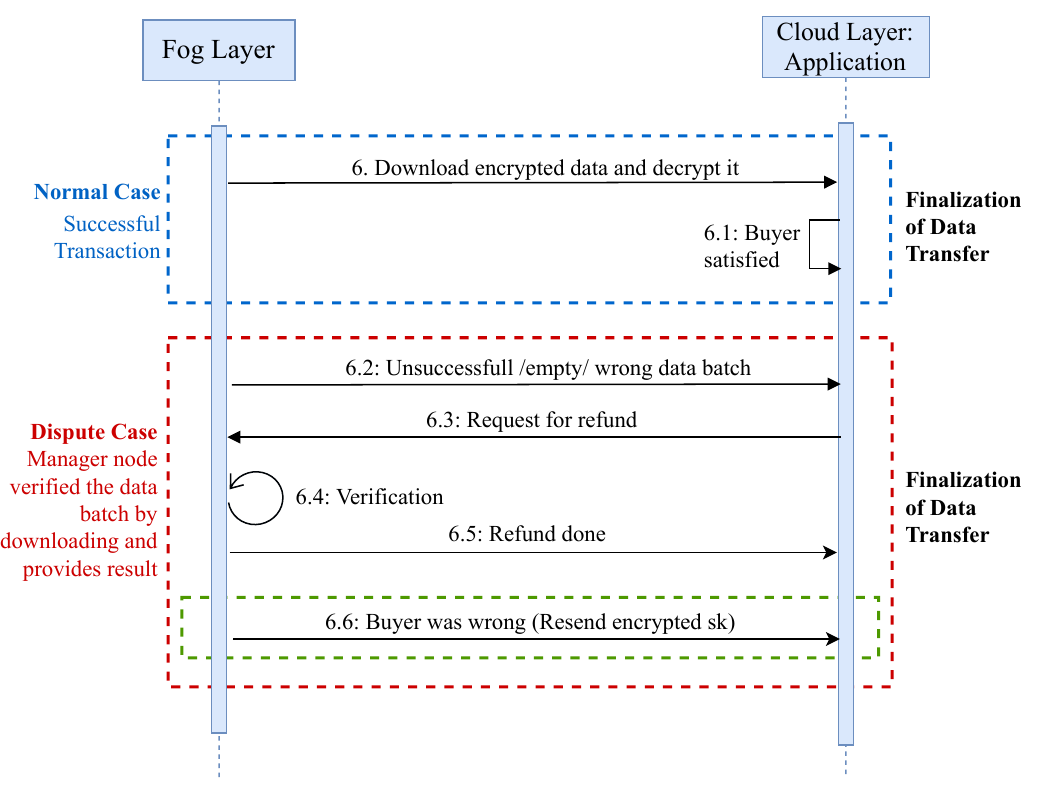
Figure 3. Sequential diagram to elaborate possible scenarios to settle down transaction